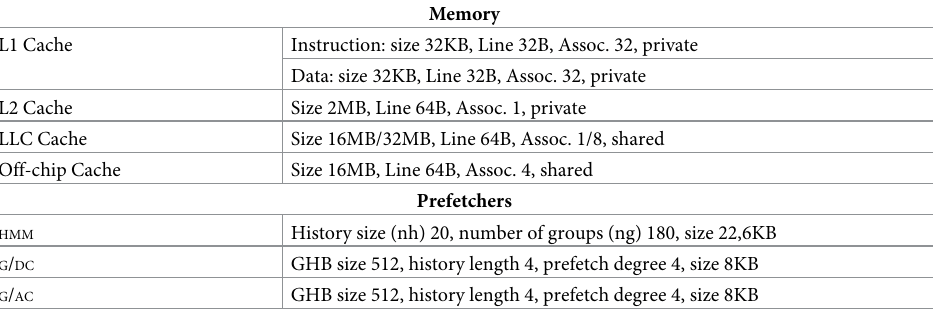
Table 1. Evaluation